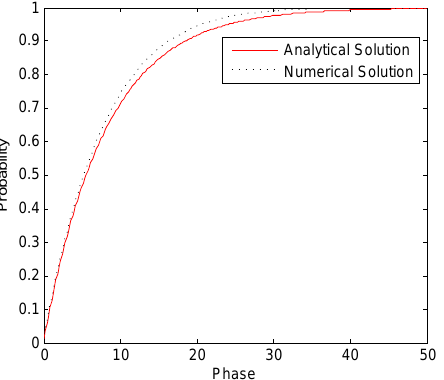
Figure 3. Phase marginal invariant probability distribution P Π ( y ) .